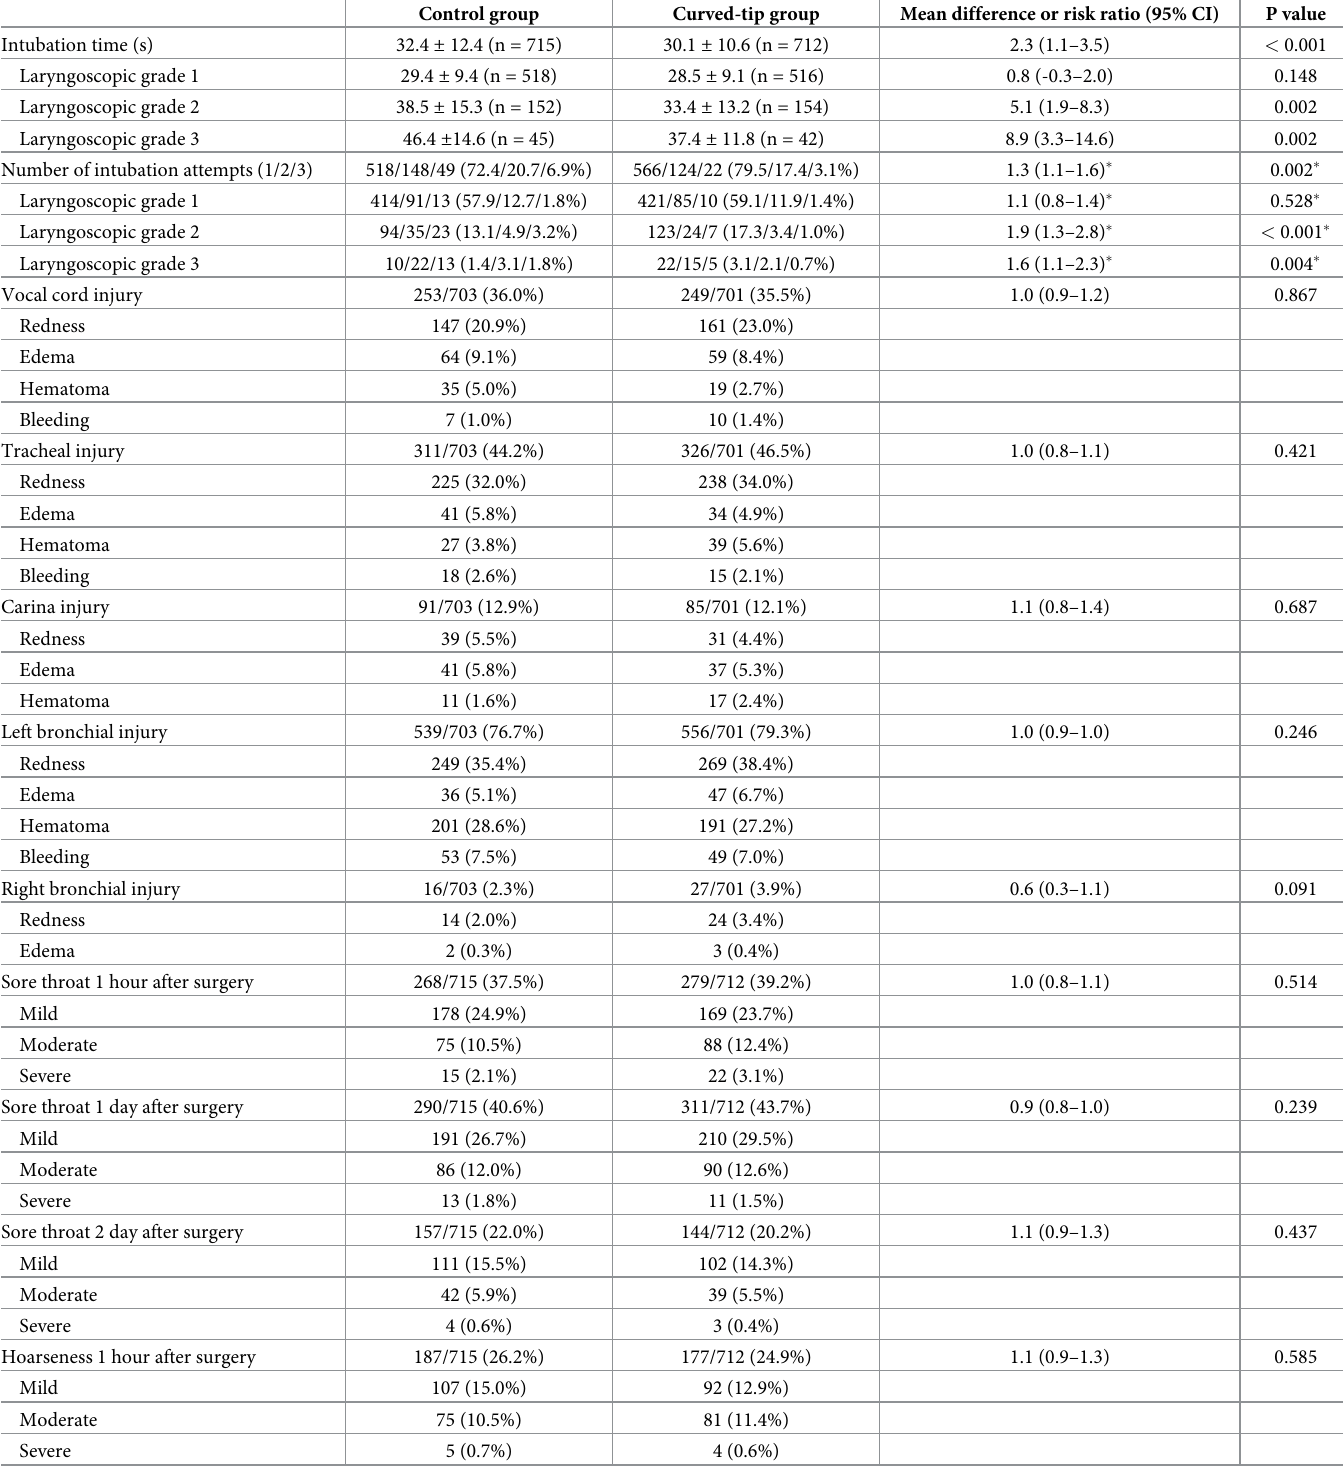
Table 4. The time and number of attempts for intubation of left-sided double-lumen tubes, the incidence and type of airway injury, and the incidence and severity of sore throat and hoarseness after